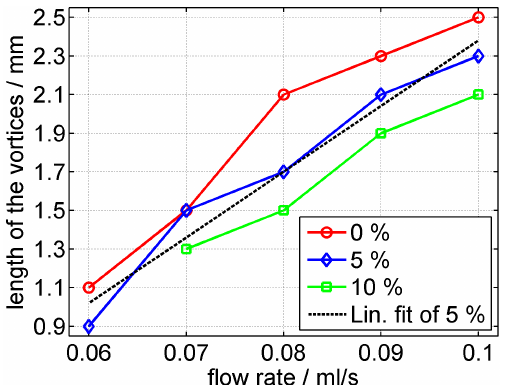
Figure 15. Measured sensitivity (defined as change in heater tem- perature divided by change in methanol fraction) of the individ- ual heaters of the array for two different flow rates of 0.06 and 0.09mLs − 1 . Two sensitivity curves are shown for a change in the methanol fraction from 0 to 5% and from 5 to 10%, respectively.